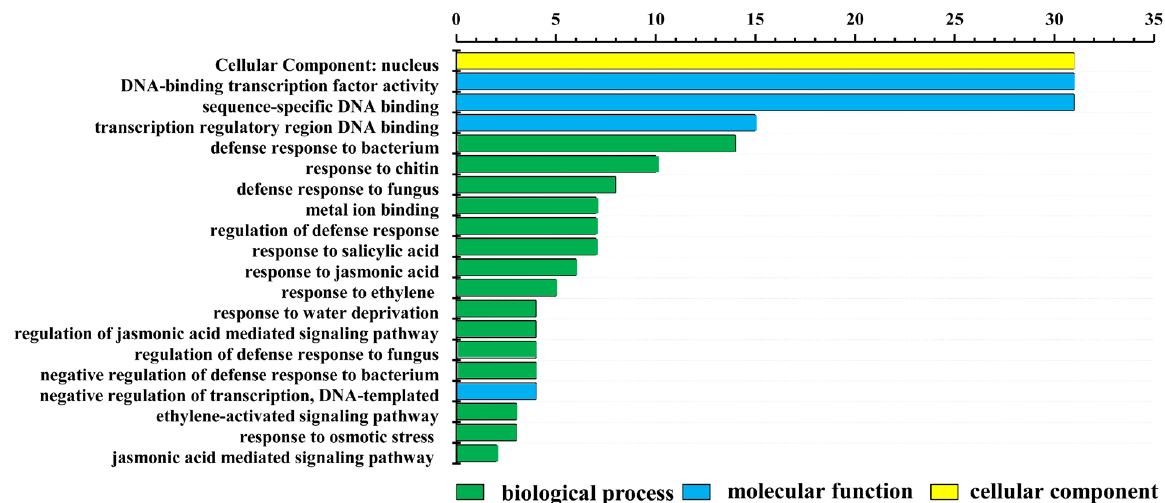
Figure 4. Gene ontology (GO) enrichment analysis of LrWRKY proteins. The top 20 GO terms of level 2 in biological process, cellular component, and molecular function were visualized. The X and Y axes represent the enriched protein numbers and the information on GO terms,